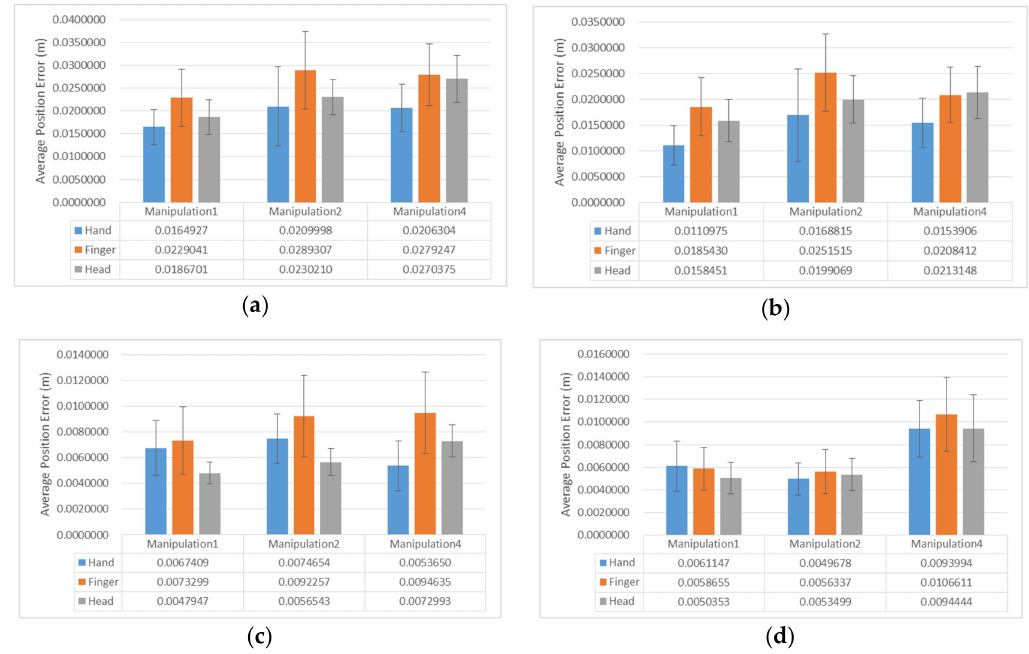
Figure 7. Position error graph ( +/ − standard deviation of the average). The mean of the ( a ) position error for each interaction, ( b ) x -axis position error for each interaction, ( c ) y -axis position error for each interaction, and ( d ) z -axis position error for each interaction.